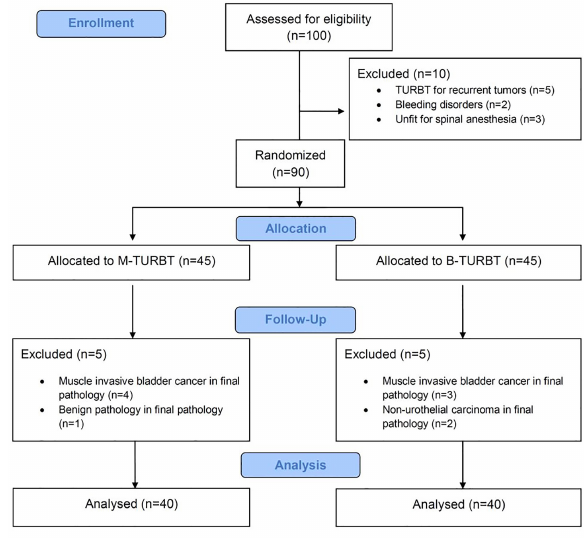
Figure 2 - CONSORT (Consolidated Standards for Reporting Trials) flow diagram for patient assessment, allocation, follow-up and